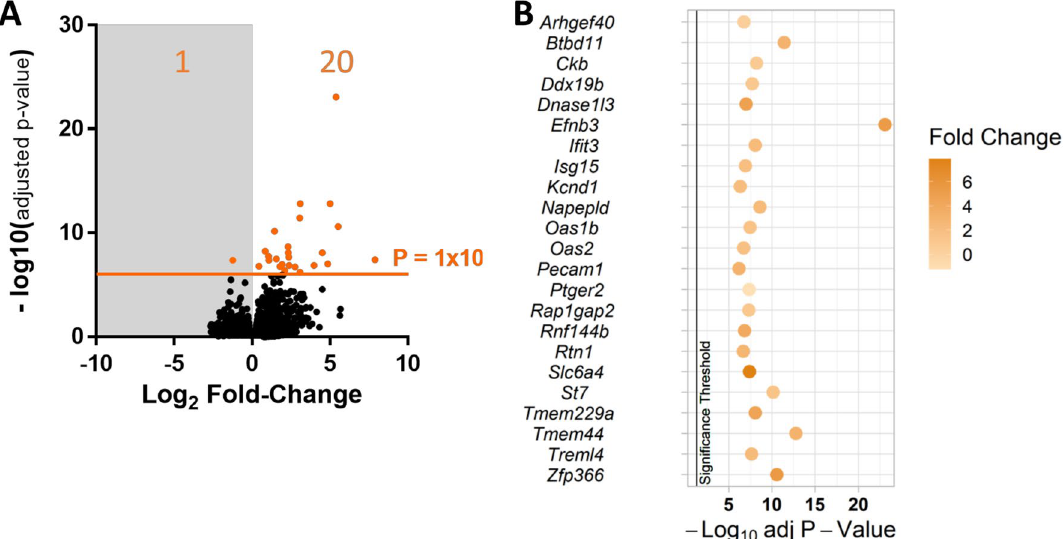
Figure 6. Summary of Spi1 over-expression genes that were significantly enriched in the IGAP dataset. ( A ) Volcano plot of the Spi1 over-expression gene expression changes relative to the empty vector control, highlighting the p ≤ 1 × 10 −6 threshold that was shown to be significantly enriched by MAGMA analysis in the IGAP dataset (MAGMA’s empirical multiple testing corrected p value 0.035). The adjusted p value for this gene set was 0.0033 and an enrichment effect size of 0.51. ( B ) Bubble plot of the genes from the Spi1 over expression dataset that were enriched for AD genetic risk via MAGMA comparison to the human IGAP database, against the Benjamini–Hochberg adjusted p values from the Spi1 over-expression RNA-sequencing data with the fold- change shown in colour. The vertical black line indicates the p value threshold of 0.05. Figure ( A ) was made in GraphPad PRISM 6 (version 3.07) and ( B ) using the ‘tidyverse’ 37 and ‘ggpubr’ 38 packages in in RStudio 39,40